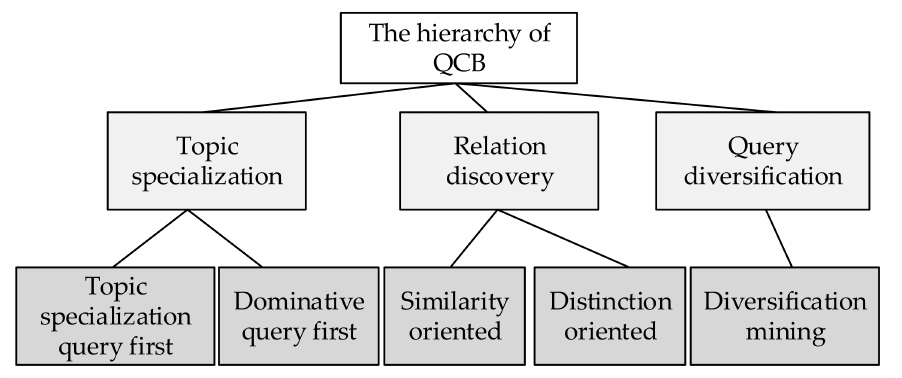
Figure 2. The hierarchy of